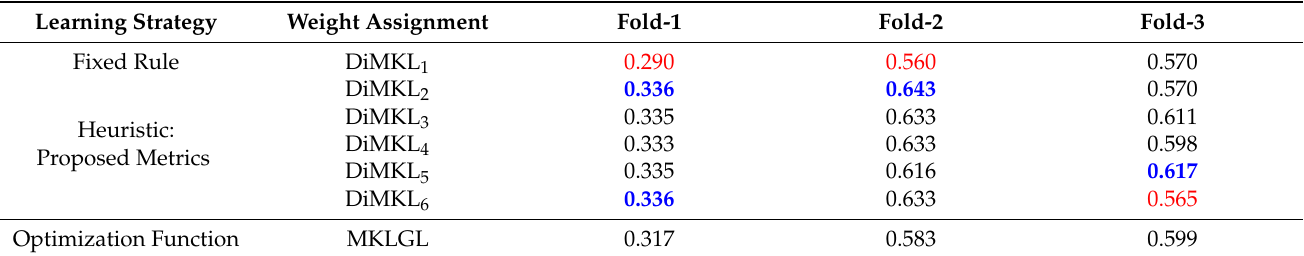
Table 3. Experiment 1: Fusing 16 RBF kernels. NAUC values are reported for each fold and MKL technique. Highest performing method is shown in blue; lowest performing is shown in red.